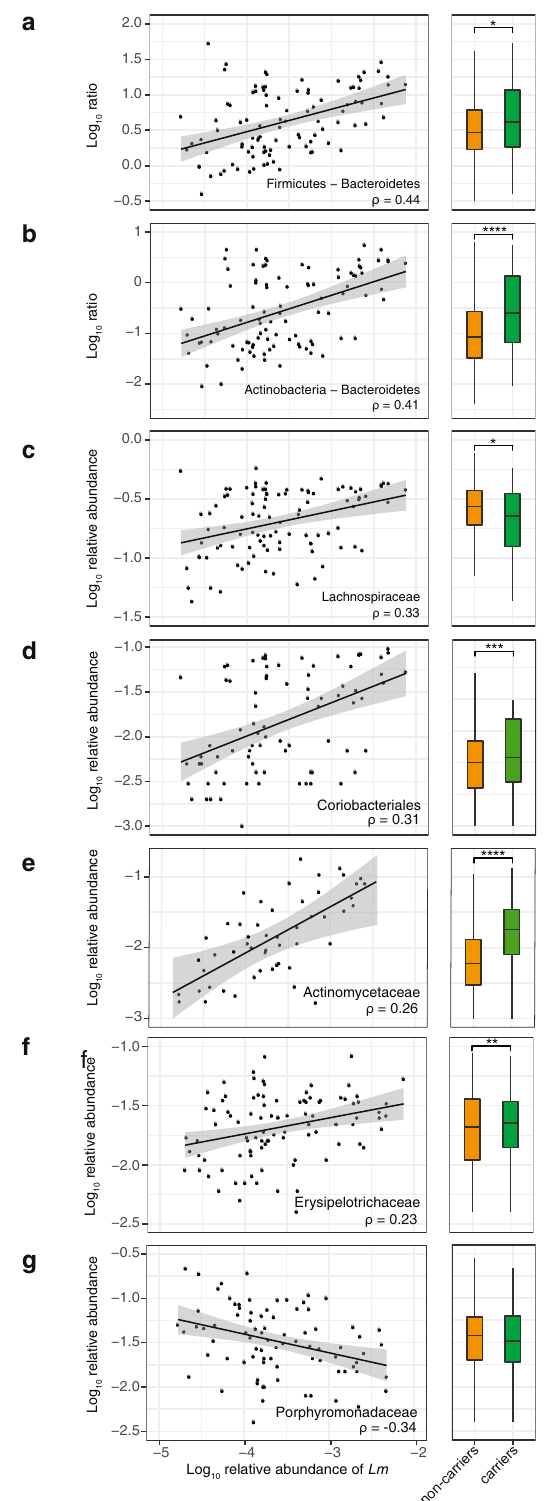
diarrhoea samples ( χ 2 = 11.702, P = 0.0018, Benjamini – Hochberg correction) is consistent with the observation that Lm can induce diarrhoea 41,42 . The difference in healthy asymptomatic donors in this cohort from France, relative to the 16S rRNA gene datasets from MG-RAST may be due to the different sensitivities of the two methods (targeted hly ampli fi cation versus total 16S ampli- fi cation), and sample selection bias re fl ecting a